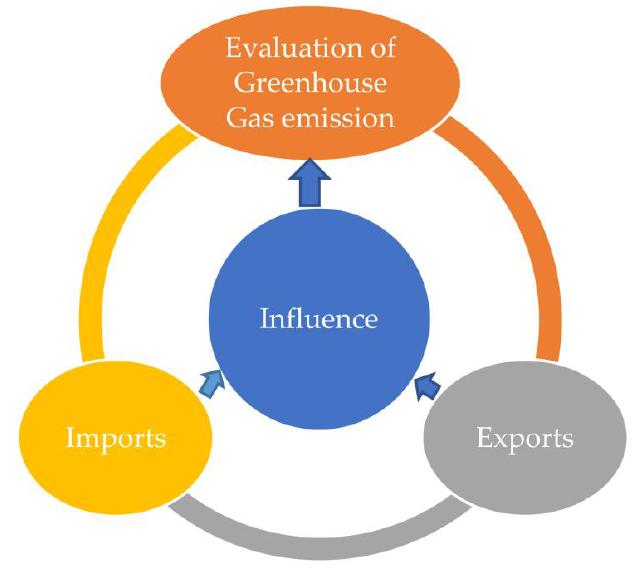
Figure 1. Objective 1.